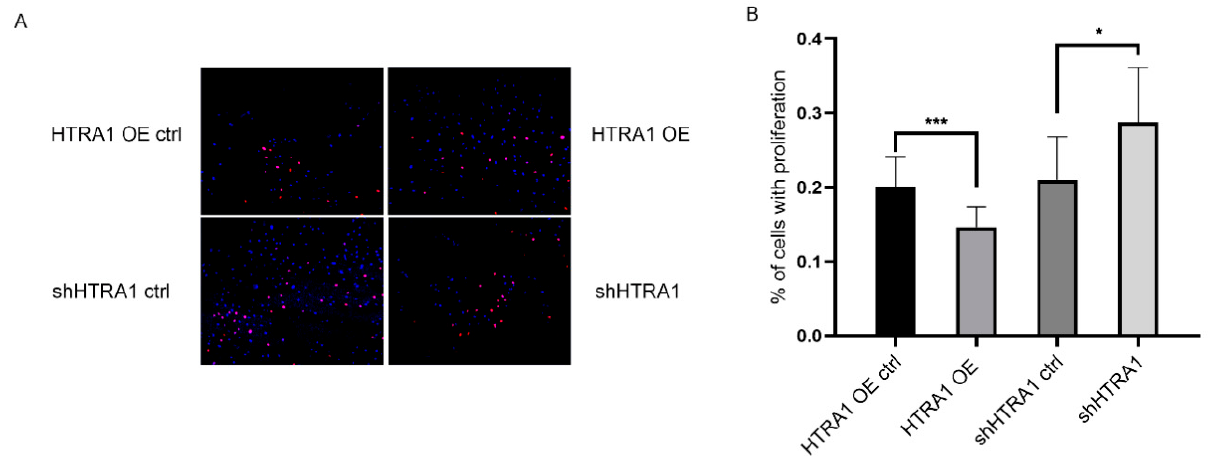
Figure 4. Effect of HTRA1 on the proliferation of ARPE-19 cell line. ( A ) Representative fluorescent image of EDU labeled ARPE-19 cell of HTRA1 overexpression and knockdown group. ( B ) Statistical result of percentage of proliferating cells. *** p < 0.001, * p < 0.05.